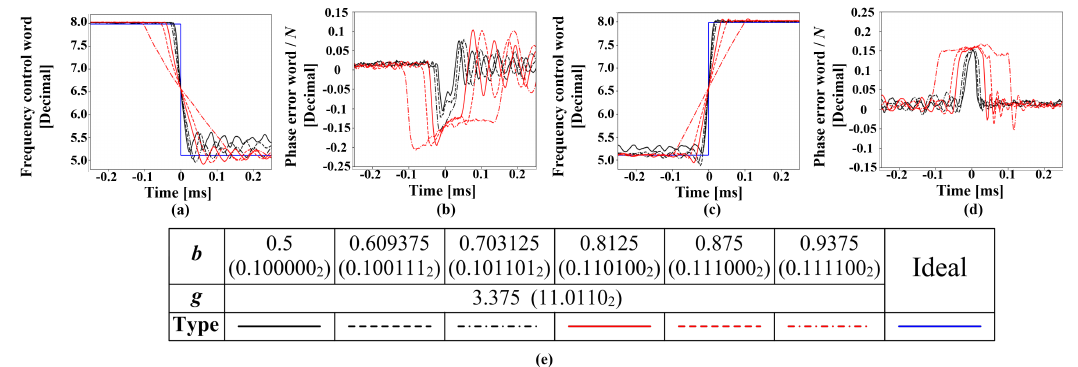
Figure 13. Measured step response with g value fixed: ( a , b ) frequency control code and detected phase error code for falling input frequency step, ( c , d ) those for rising input frequency step, ( e ) the legend for each parameter. The timing in code variations is shifted so as to have the same 50% transition point of the frequency control code. The frequency control code is also shifted up to match the DCO input range.